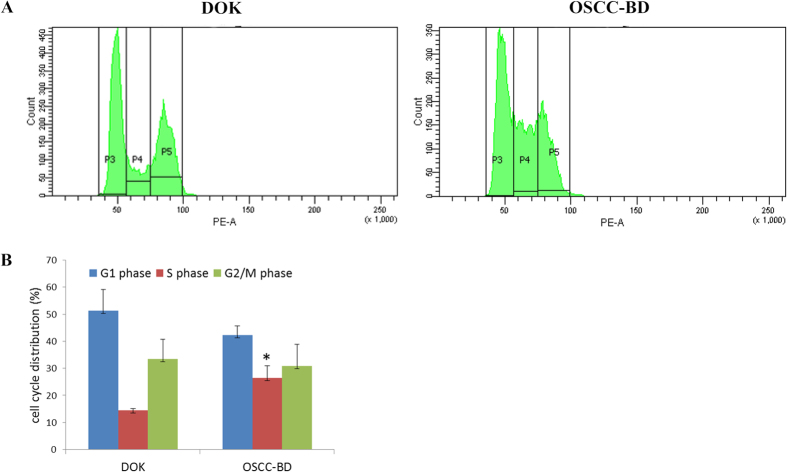
The cell cycle distribution of DOK cells and OSCC-BD cells by flow cytometry.(A) Flow cytometric results showed an accumulation of OSCC-BD cells in S cell-cycle phase. (B) The histogram showed the percentage of OSCC-BD cells in S phase (26.4 ± 4.6%) was significantly higher than that of DOK cells (14.5 ± 0.6%). Data are expressed as mean ± SD of three independent experiments done. *p < 0.05.